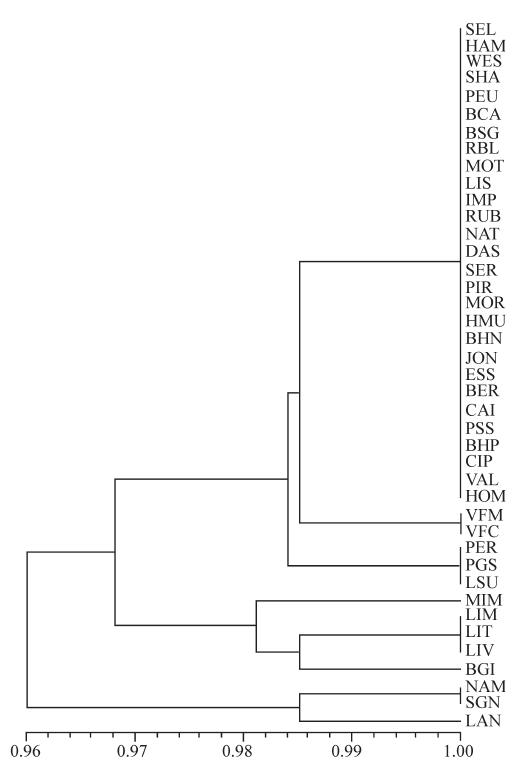
Figure 2 - Dendrogram illustrating the relationships among 41 sweet or- ange Citrus sinensis cultivars. The dendrogram was draw based on un- weighted pair group method with averages (UPGMA) cluster analysis using the similarity matrix derived from 50 microsatellite